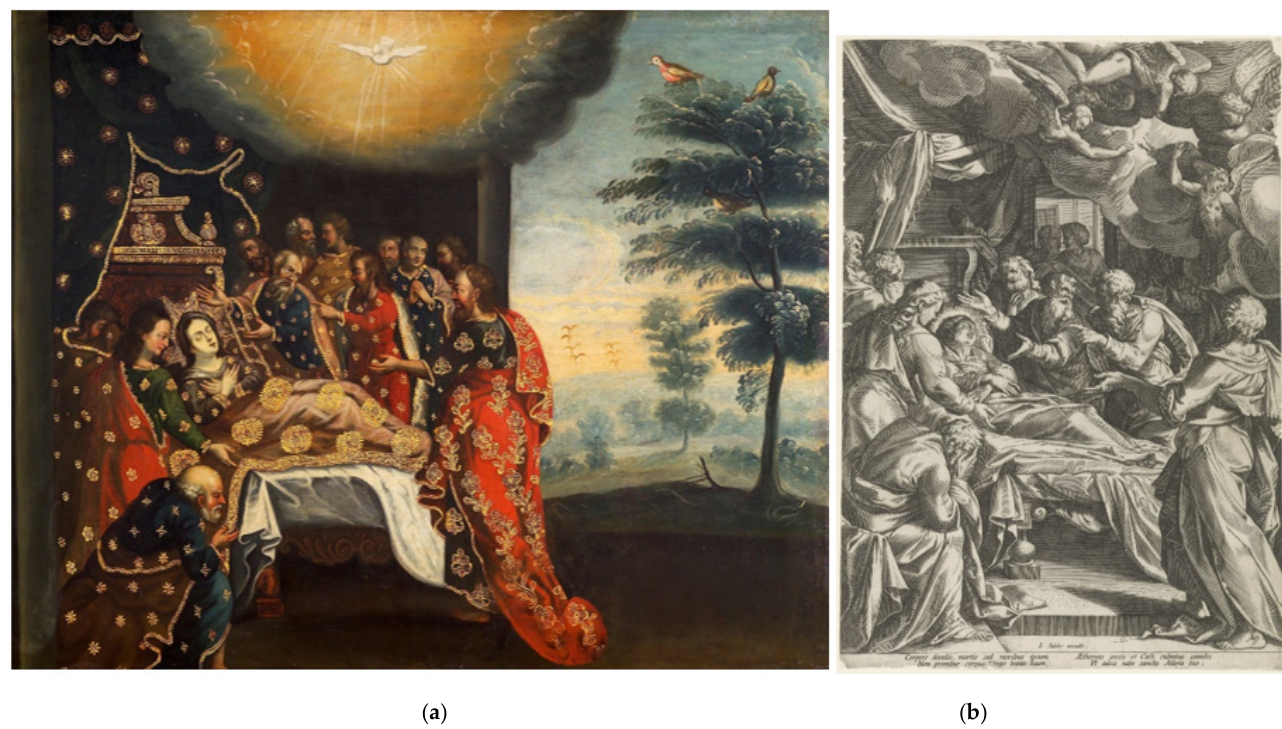
Figure 13. ( a ) Unidentified artist, The Dormancy of the Virgin , 1730–1770, oil on canvas, Museo de Arte de Lima (MALI), 131 × 103 com. Credit line: Wikimedia Commons. ( b ) Jan SadelerI (publisher and possibly engraver) after an engraving by Cornelis Cort and a design by Federico Zuccaro, The Dormancy of the Virgin , 1567–1600, engraving. Credit line: Rijksmu- seum.